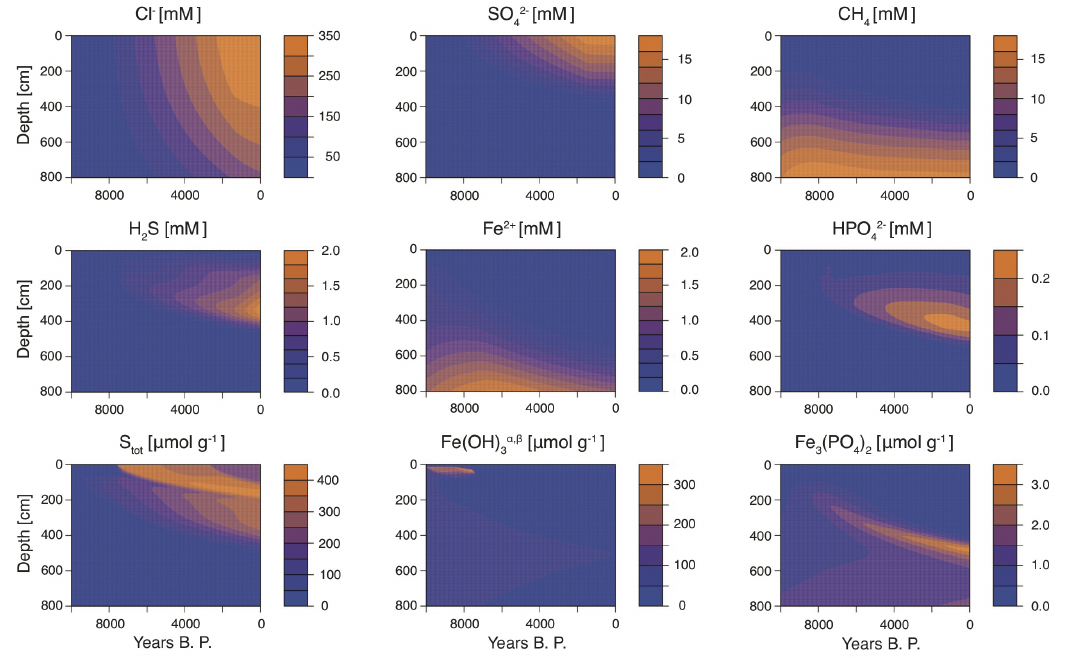
Figure 7. Transient evolution of selected porewater and sediment profiles with depth as calculated for site 4 using the diagenetic model.